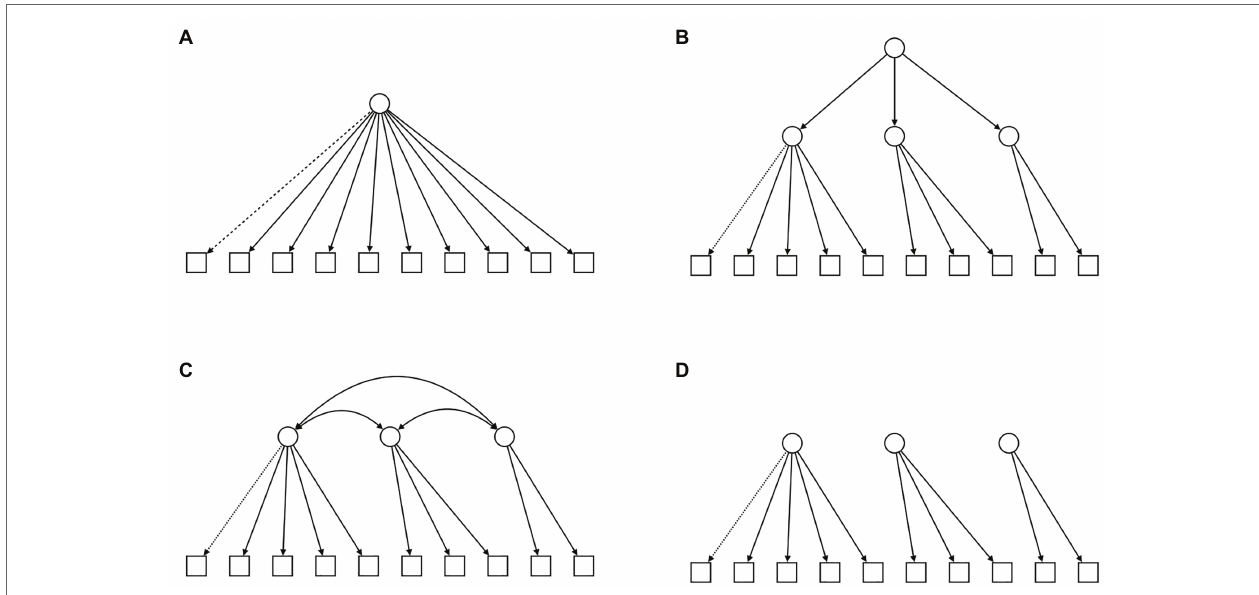
FIGURE 2 | The figure summarizes the four core models, compared by confirmatory factor analysis. The dashed line references the challenging role of awe and refers to that we computed every model twice (with/without awe). (A) Shows the simple one-factor model, as suggested in our exploratory parallel analysis, (B) illustrates a hierarchical model with a higher-order general factor, above the proposed three first-order factors, (C) shows the intercorrelated three-factor model, and (D) the orthogonal alternative without factor intercorrelations.